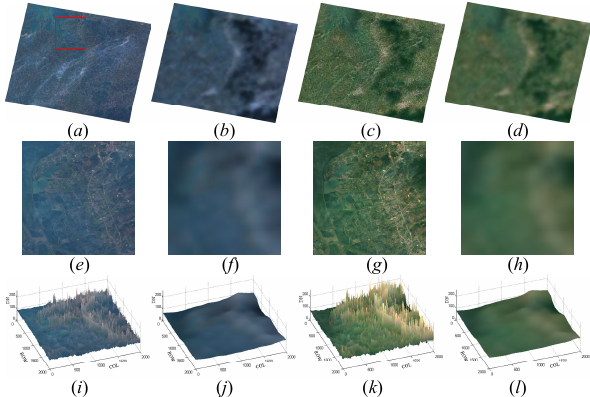
Figure 3. Color correction results. ( a - d ) Atmospheric corrected image I srcAC , low-frequency signal of I srcAC , color-corrected image I dstAC , low-frequency signal of I dstAC ; ( e - h ) Enlarged detail of the